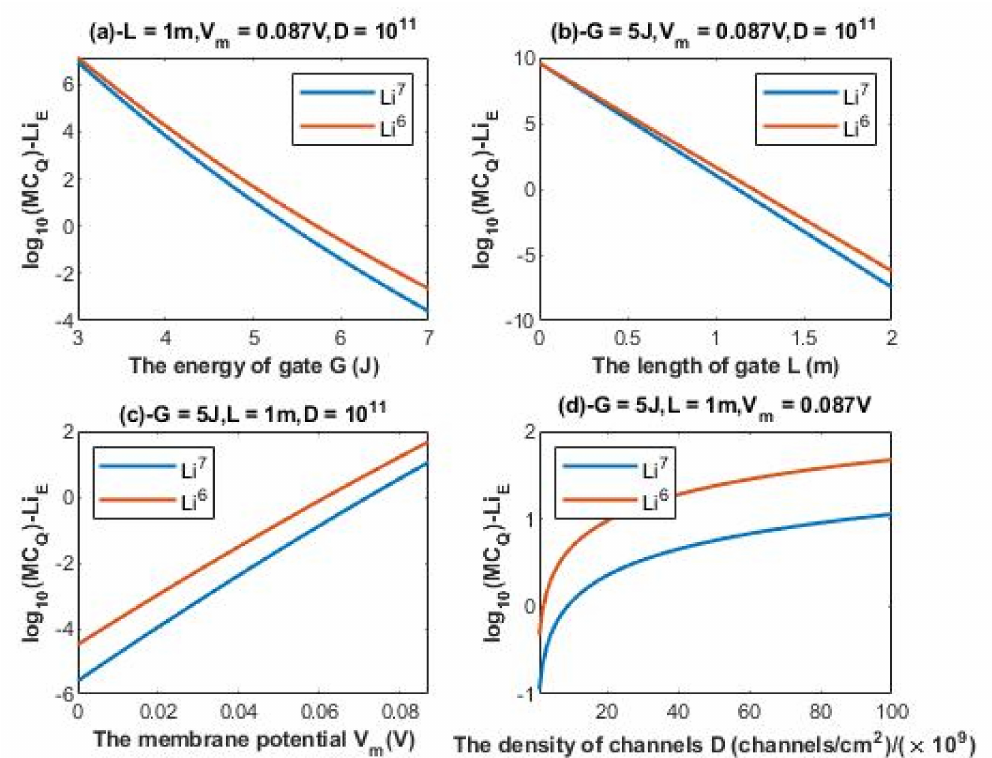
Figure 6. ( a ): The figure represents the relationship between the common logarithm of quantum membrane conductance of the extracellular lithium isotopes log the gate G by setting L = 1 m, V m = 0.087 V and D = 10 11 and across the range of G from 3 J to 7 J. ( b ): The figure represents the relationship between the common logarithm of quantum membrane conductance of the extracellular lithium isotopes log setting G = 5 J, V m = 0.087 V and D = 10 11 and across the range of L from 0 m to 2 m. ( c ): The figure represents the relationship between the common logarithm of quantum membrane conductance of the extracellular lithium isotopes log G = 5 J, L = 1 m and D = 10 11 and across the range of membrane potential from 0 V to 0.087 V. ( d ): The figure represents the relationship between the common logarithm of quantum membrane conductance of the extracellular lithium isotopes log setting G = 5 J, L = 1 m and V m = 0.087 V and across the range of D from 10 9 to 10 11 channels/cm 2